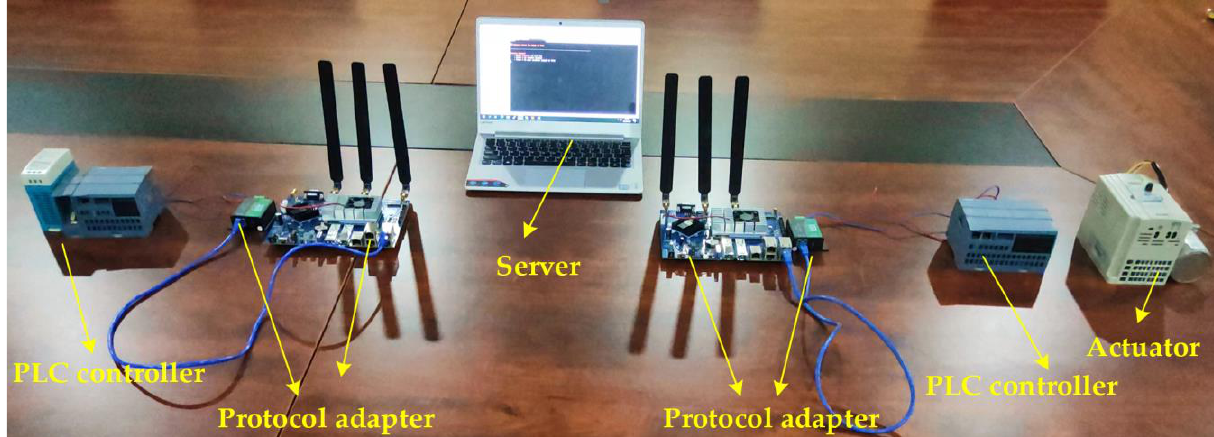
Figure 9. The internal connection of the wireless PLC prototype for Modbus RTU.